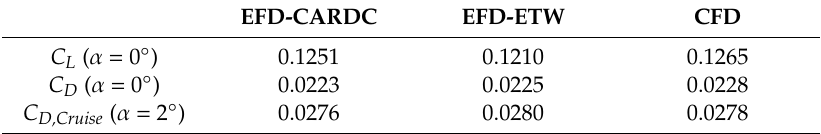
Table 3. Aerodynamic coe ffi cients comparison of CHN-T1 ( Ma = 0.78, Re = 3 × 10 6 ).